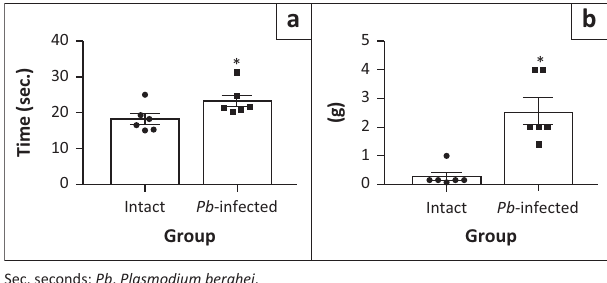
FIGURE 1-A1: Response thermal and mechanical noxious stimuli. (a) Latency to withdraw paw during cold plate test. (b) Withdrawal threshold in Von Frey